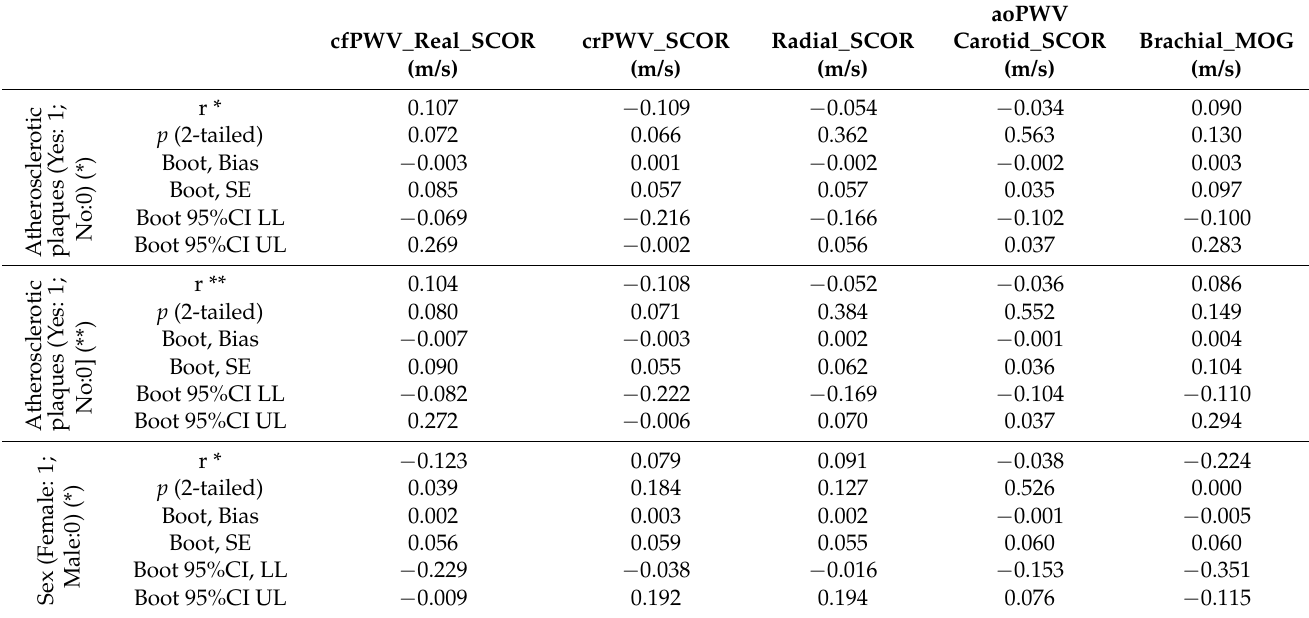
Table 6. Association between stiffness parameter and plaque presence or sex (adjusted by age and/or sex).